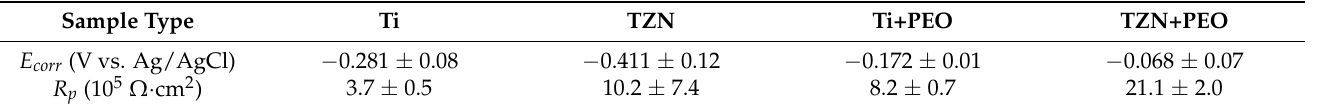
Figure 5. Polarization curves in Ringer’s solution for the uncoated and PEO coated Ti and TZN samples. Table 4. Corrosion properties of the PEO coatings on Ti and TZN samples.